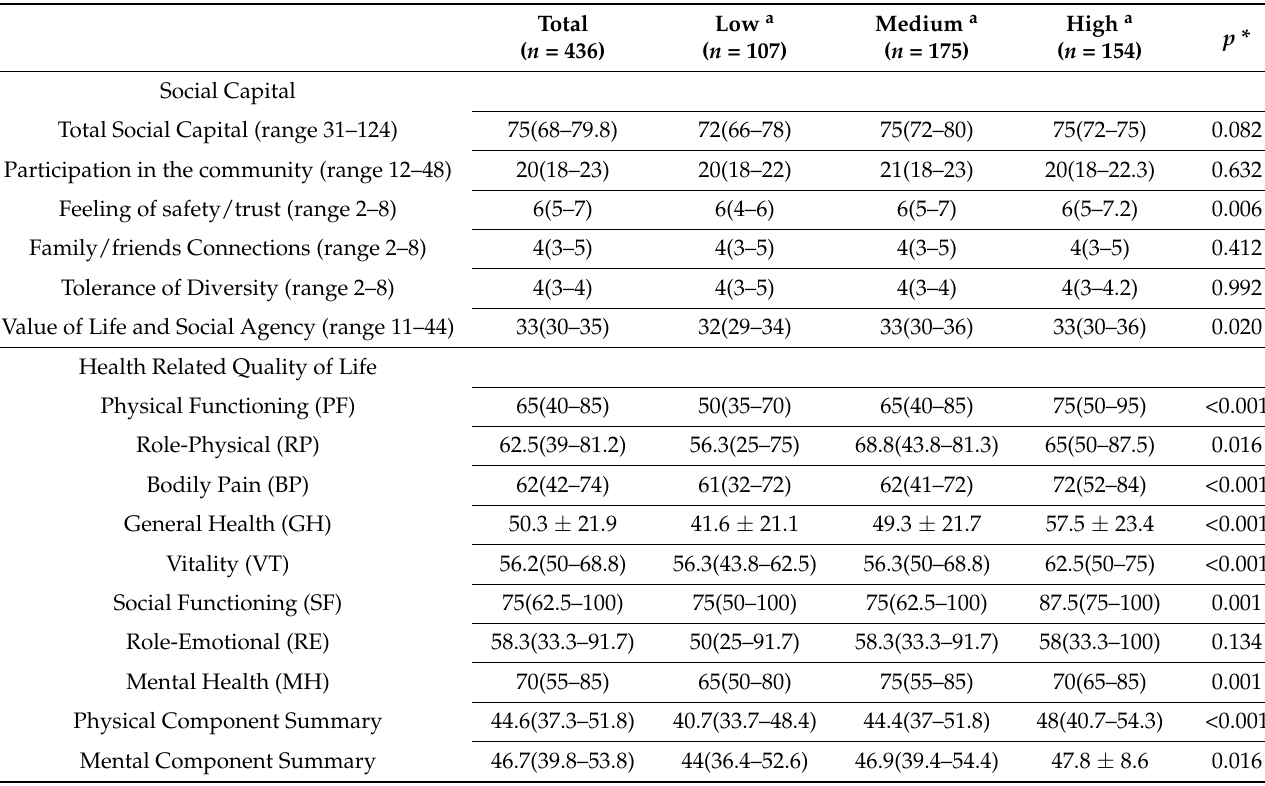
Table 2. Differences Social capital and Health Related Quality of Life (HRQL) per Mediterranean Diet adherence level ( n =